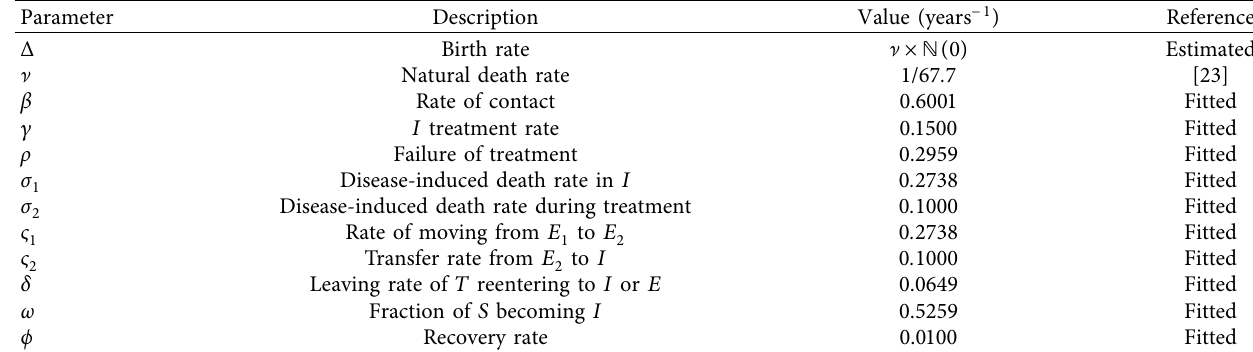
Table 1: Descriptions of parameters and their numerical